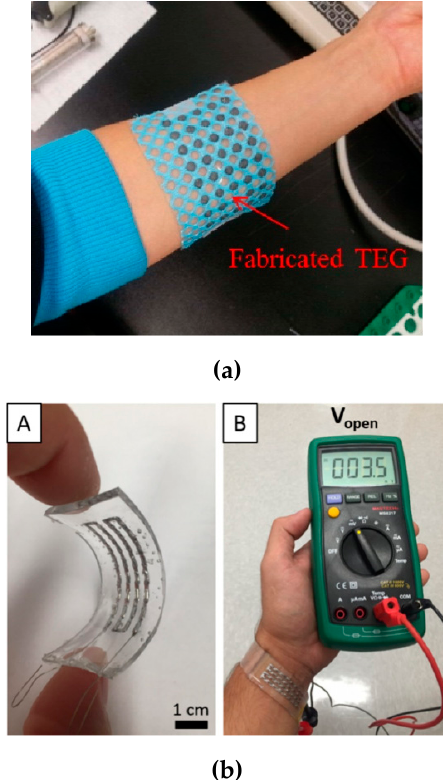
Figure 13. ( a ) Flexible TEG fabricated using dispenser printing technology [144]. ( b ) Flexible device and test configuration: (A) flexible device tested, (B) circuit voltage open at room temperature